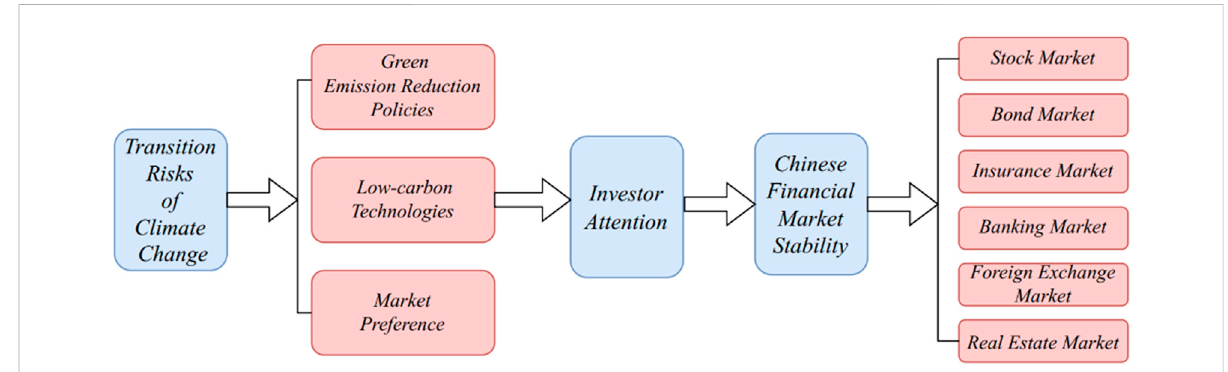
FIGURE 1 “ Climate change — change in investor attention — fi nancial stability ” transmission